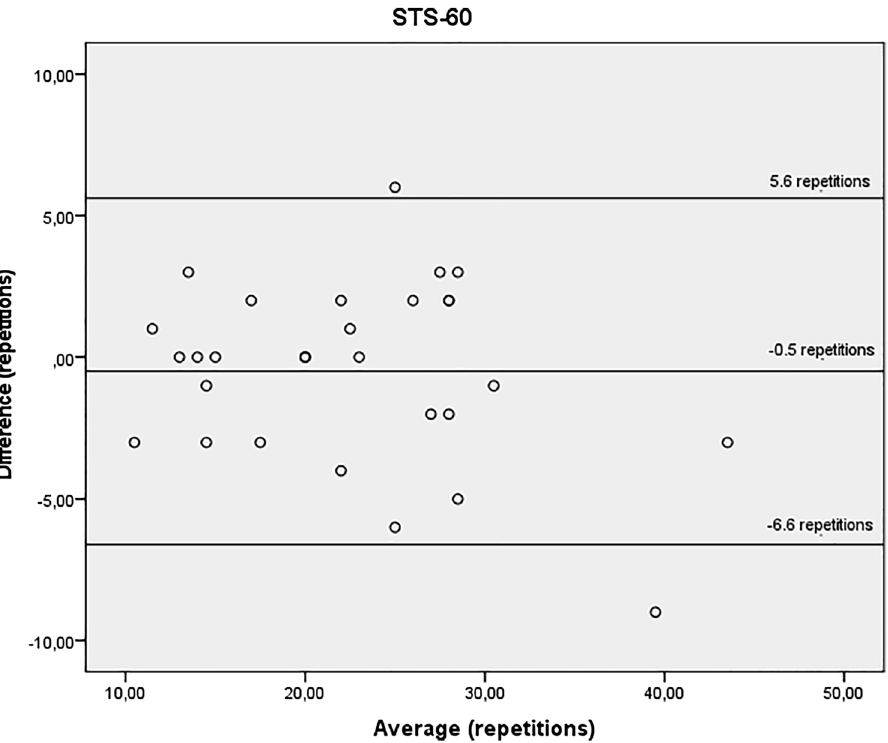
Figure 2. Bland–Altman plots showing agreement for the time required to perform the sit-to-stand-to-sit 60 test, obtained before the haemodialysis session and on a non-dialysis day by the same rater. Y axis difference between (non-dialysis—before the haemodialysis session) in seconds. X axis average (non-dialysis + before the haemodialysis session)/2